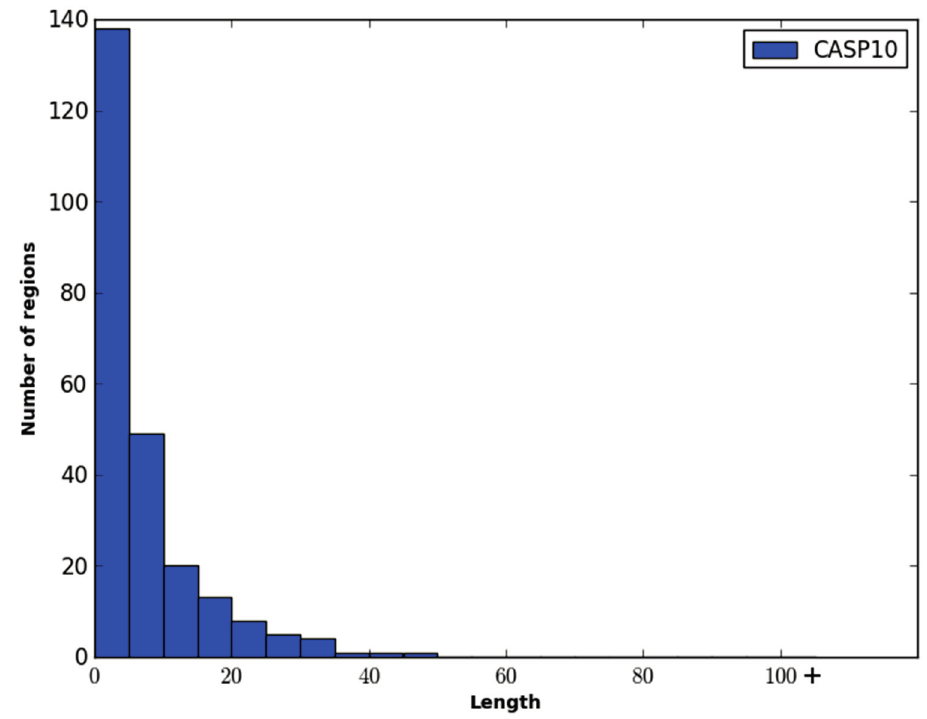
Figure 7. Distribution of the length of disordered regions in the CASP10 dataset. Each bin represents a range of five residues, and the last bin represents the number of disordered regions that have a length greater than 100 residues.